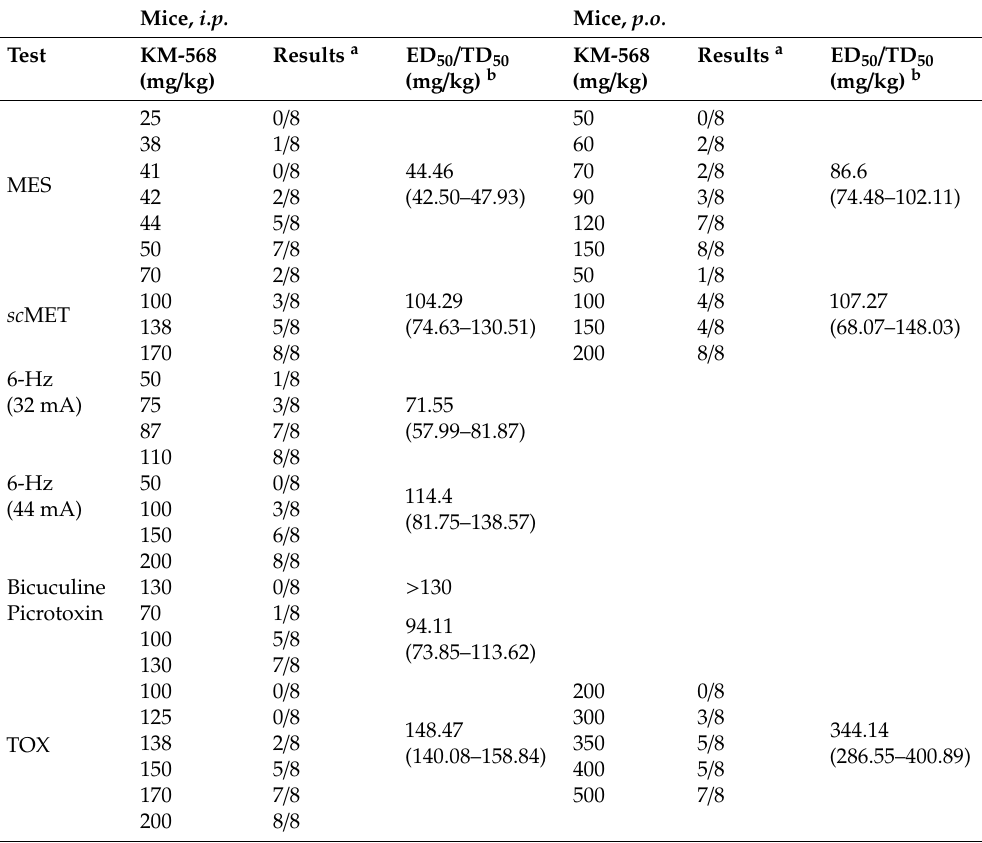
Table 1. Biological response in anticonvulsant and neurotoxicity evaluation in mice after intraperitoneal ( i.p .) and oral ( p.o .) administration of KM-568. Mice, i.p. Mice, p.o.